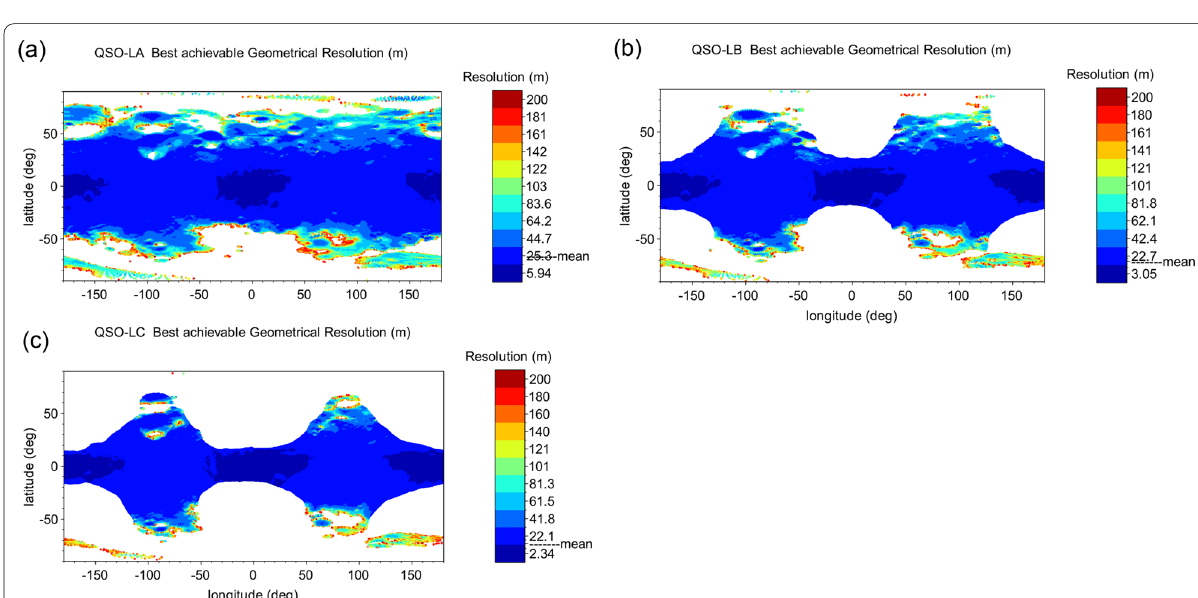
Fig. 9 Coverage and geometric (spatial) resolution of MIRS mapping from QSO‑LA ( a ), QSO‑LB ( b ), and QSO‑LC ( c ). Areas with resolution above 200 m are not displayed. a At QSO‑LA, percentage of surface covered at resolution better than 100 m is 99% for areas within 30° latitudes and ± 85% for all areas, at resolution better than 40 m is 99% for areas within 30° latitudes and 75% for all areas, at resolution better than 30 m is 98% for ± areas within 30° latitudes and 70% for all areas, at resolution better than 20 m is 92% for areas within 30° latitudes and 58% for all areas, and at ± ± resolution better than 10 m is 37% for areas within 30° latitudes and 21% for all areas. b At QSO‑LB, percentage of surface covered at resolution ± better than 100 m is 92% for areas within 30° latitudes and 67% for all areas, at resolution better than 40 m is 92% for areas within 30° latitudes ± ± and 63% for all areas, at resolution better than 30 m is 91% for areas within 30° latitudes and 61% for all areas, at resolution better than 20 m is ± 90% for areas within 30° latitudes and 56% for all areas, and at resolution better than 10 m is 75% for areas within 30° latitudes and 43% for all ± ± areas. c At QSO‑LC, percentage of surface covered at resolution better than 100 m is 79% for areas within 30° latitudes and 54% for all areas, at ± resolution better than 40 m is 79% for areas within 30° latitudes and 52% for all areas, at resolution better than 30 m is 79% for areas within 30° ± ± latitudes and 50% for all areas, at resolution better than 20 m is 79% for areas within 30° latitudes and 48% for all areas, and at resolution better ± than 10 m is 71% for areas within 30° latitudes and 41% for all ±